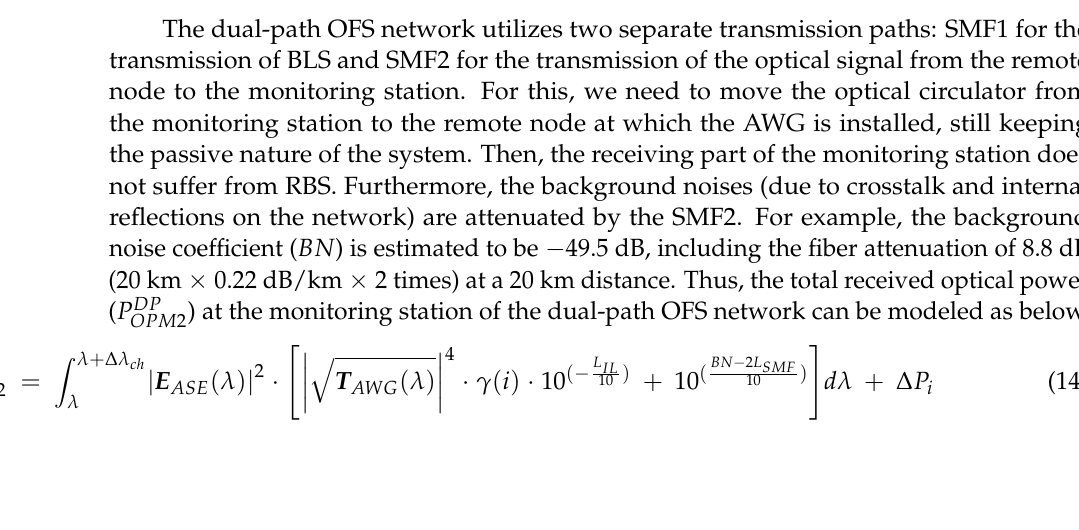
Figure 7. Architecture of the dense wavelength division multiplexing (DWDM)-passive optical fiber sensor network based on dual-path configuration.